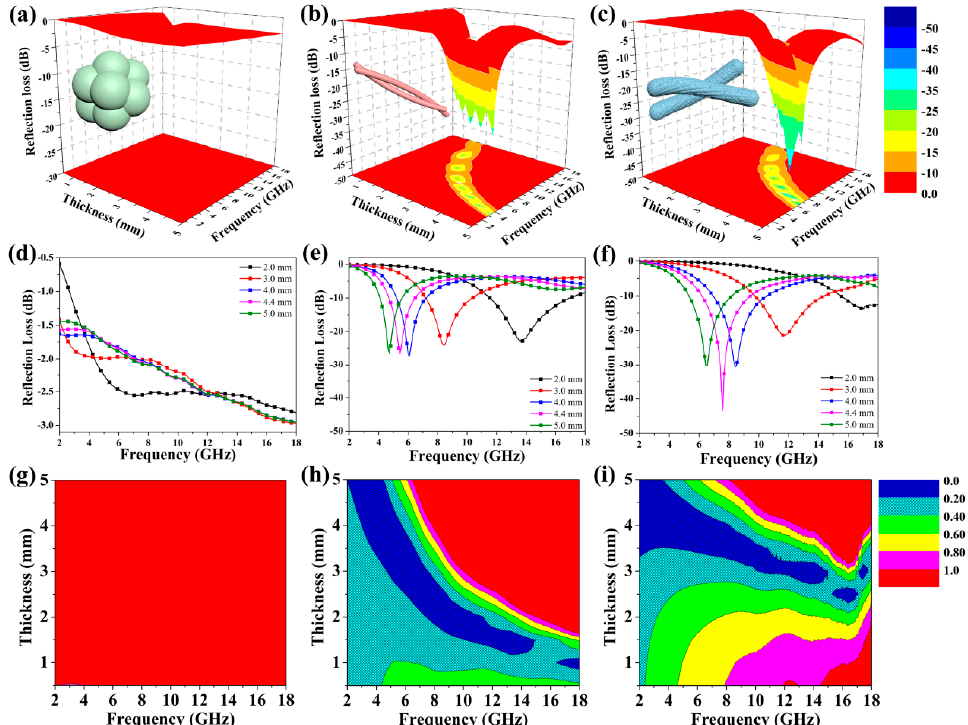
Figure 5. The calculated 3D RL map with a thickness of 0.5–5.0 mm for ( a ) HCl-PPy, ( b ) PDA/PPy and ( c ) PDA/Ppy/ND; the calculated RL value with certain thicknesses for ( d ) HCl-Ppy, ( e ) PDA/PPy and ( f ) PDA/PPy/ND; and the EM impedance matching degree Δ maps for ( g ) HCl-PPy, ( h ) PDA/PPy and ( i ) PDA/Ppy/ND. The inserts are the schematic for the related morphologies.